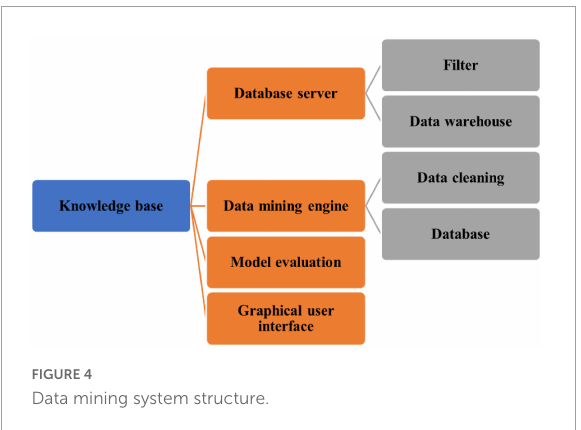
FIGURE4 Data mining system